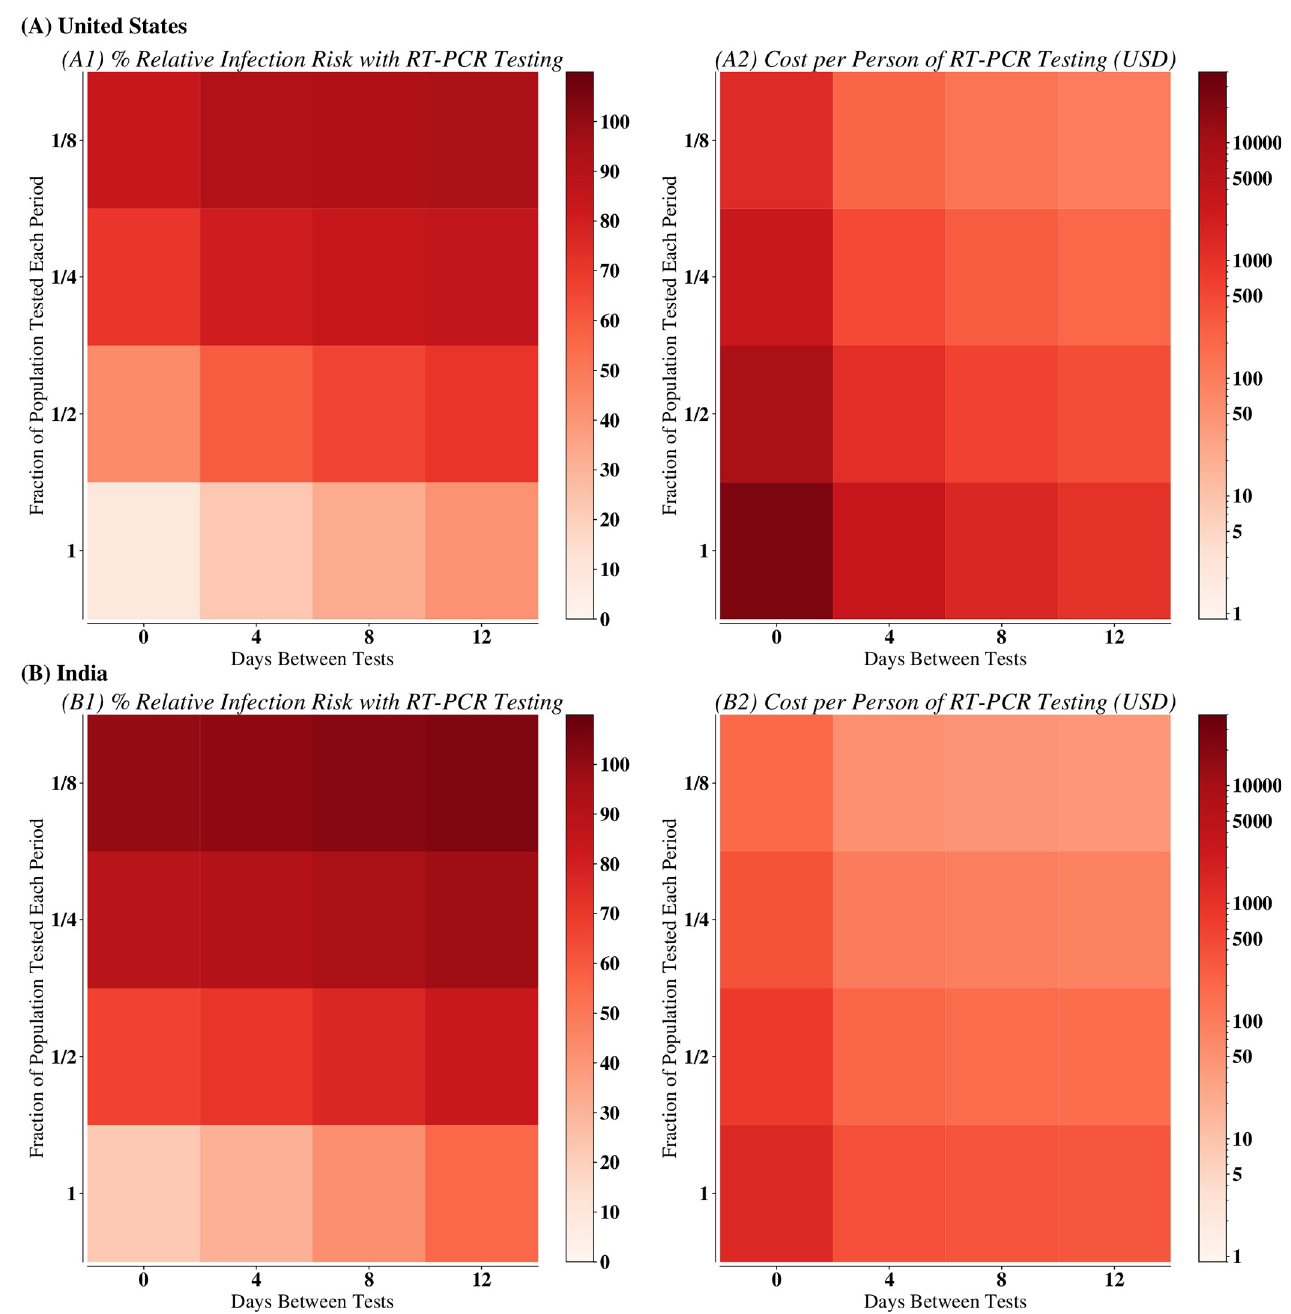
Fig 1. Relative infection risk and cost of testing for various RT-PCR scenarios in (A) United States and (B) India. Subplot (1) shows the relative infection risk of RT-PCR tests being used at the given frequency and coverage, compared with the scenario with no mitigation. Subplot (2) provides the cost of that testing scenario assuming that all susceptible individuals are tested at the given frequency and